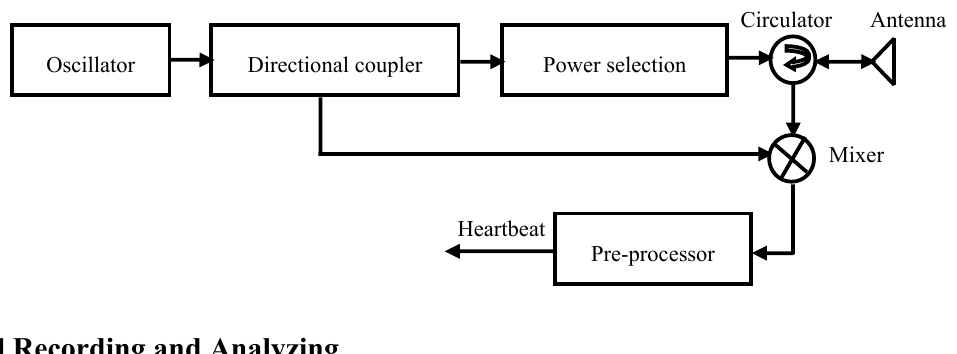
Figure 1. The block scheme of the microwave